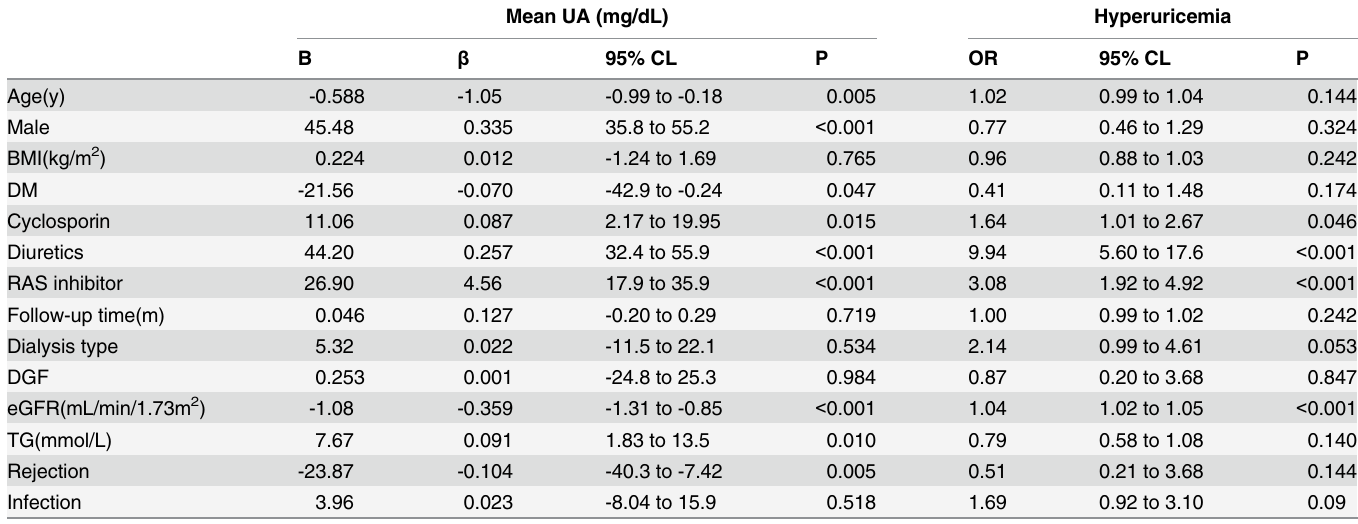
Table 5. Factors could impact UA level and risk factors for hyperuricemia. Abbreviations as in Table 1; variables assignment for logistic regression: Dialysis type (prensence for peritoneal; lack for